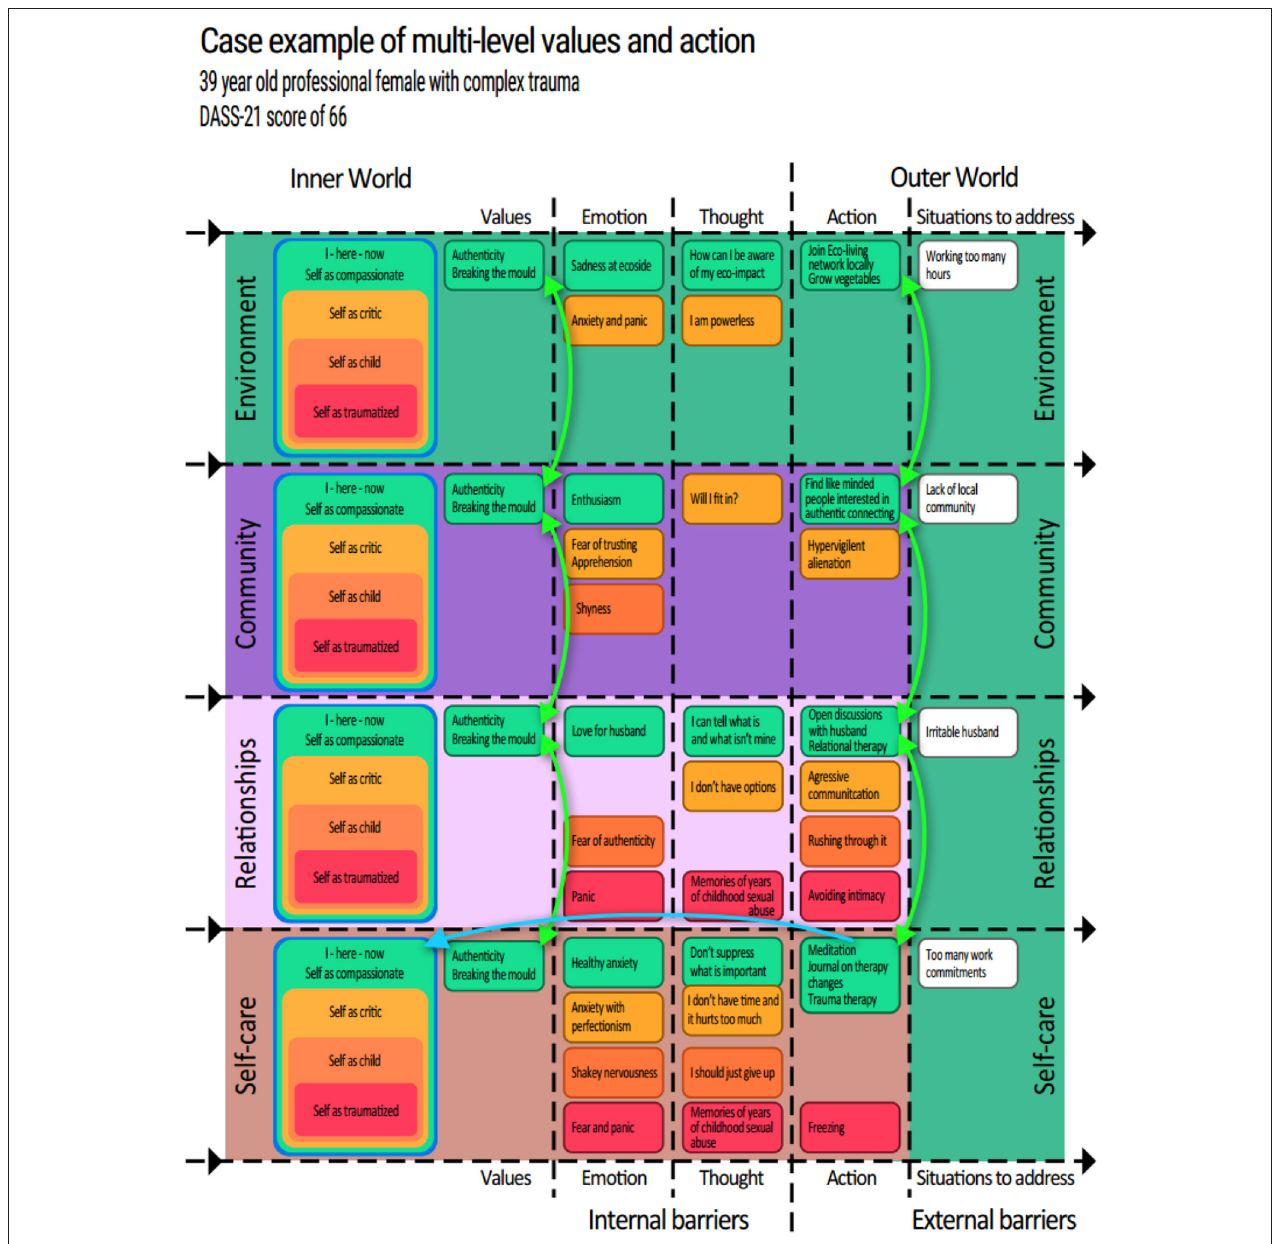
FIGURE 3 | First presented at the European Behavioural Pharmacology Society preconference Workshop, 2021. Reprinted with